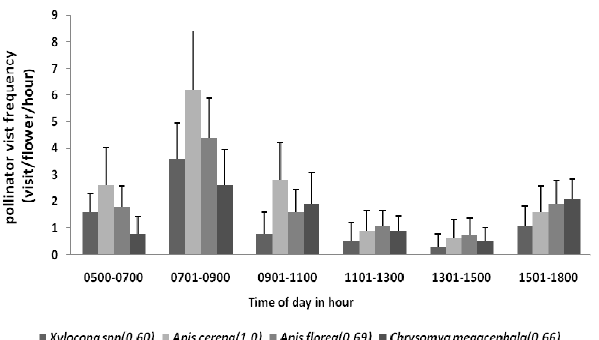
Fig. 7. Frequency of pollinator visits in respect to the time of day for L. speciosa in the year 2013 (values in parentheses indicate LSD values for 5%)